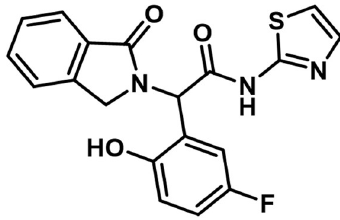
Figure 27. Chemical structure of fourth-generation allosteric EGFR inhibitor